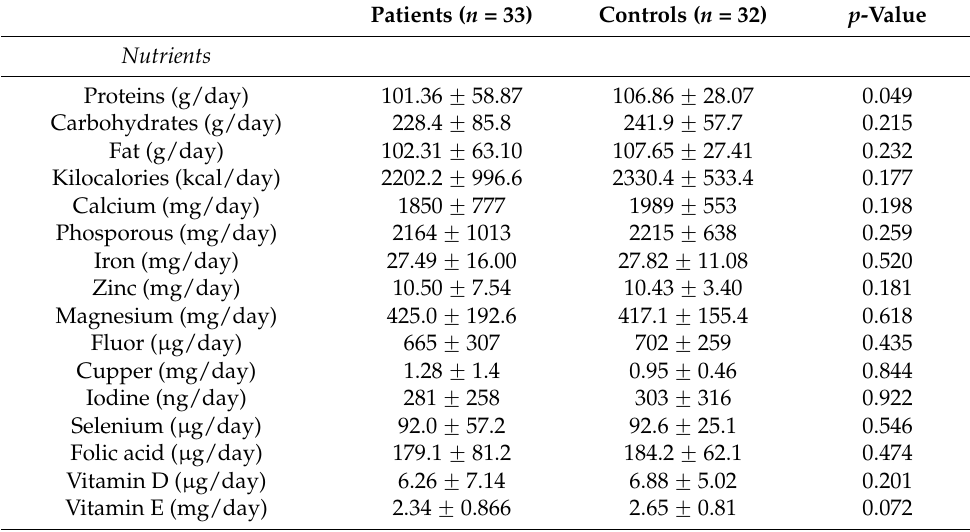
Table 3. Nutrient intake